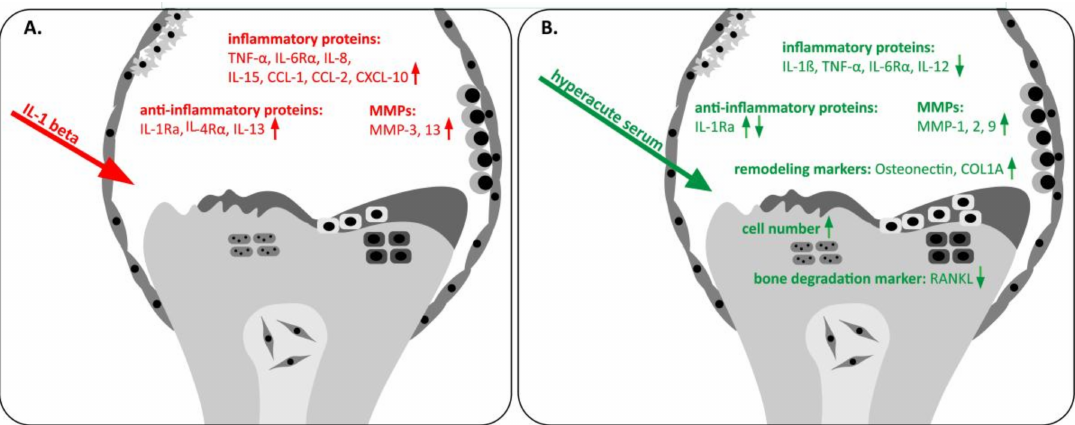
Figure 9. The e ff ect of IL-1 β stimulation and hyperacute serum treatment on osteoarthritic knee tissues. ( A ) IL-1 β stimulation enhanced the level of inflammatory cytokines such as TNF- α , IL-6R α , IL-8, IL-15, CCL-1, CCL-2, and CXCL-10 in an osteoarthritic tissue co-culture model, while the level of MMP-3 and MMP-13 also increased. ( B ) Hyperacute serum treatment reduced IL-1 β , TNF- α , IL-6R α , IL-12, and RANKL, while it increased the number of cells in all the three tissue types, MMP-1, -2, and -9, osteonectin, and COL1A1. The concentration of IL-1RA increased after adding hyperacute serum, but it also decreased at the end of the culture